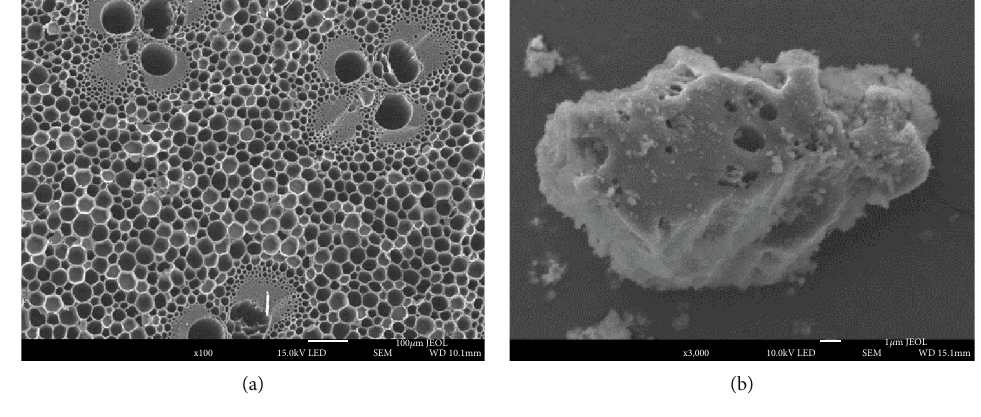
Figure 1: SEM of C (a) and Fe/Mn-C-LDH (b).